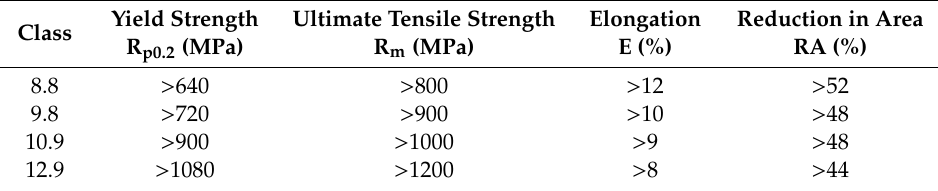
Table 2. Nominal values of mechanical properties for high-strength bolt classes [29].